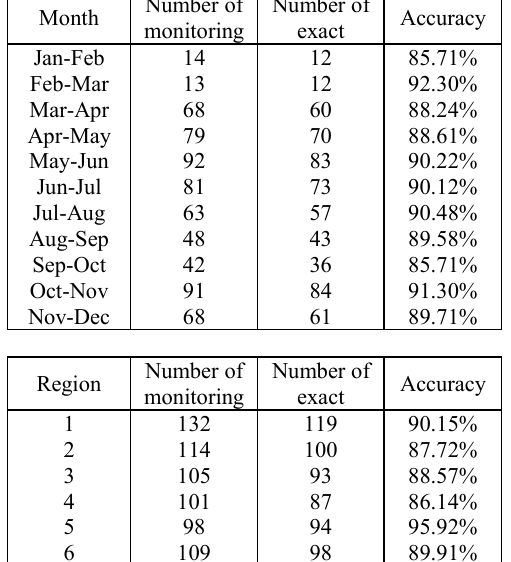
Figure 7. The phenological feature is more prominent in the differences between grain crops and artificial turf (green: early season rice, yellow: artificial